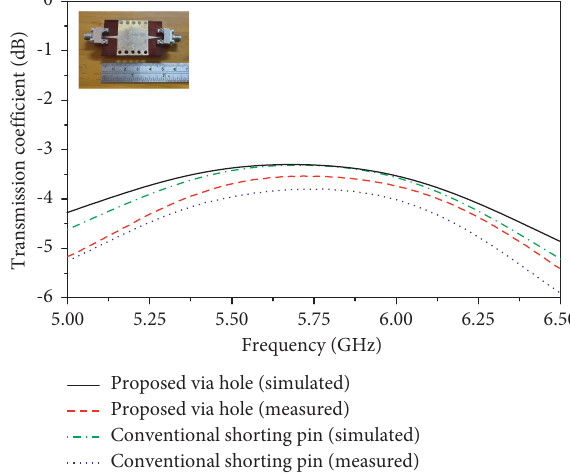
Figure 6: Transmission coefficient resulting from the via hole and shorting pin fabricated on the PI